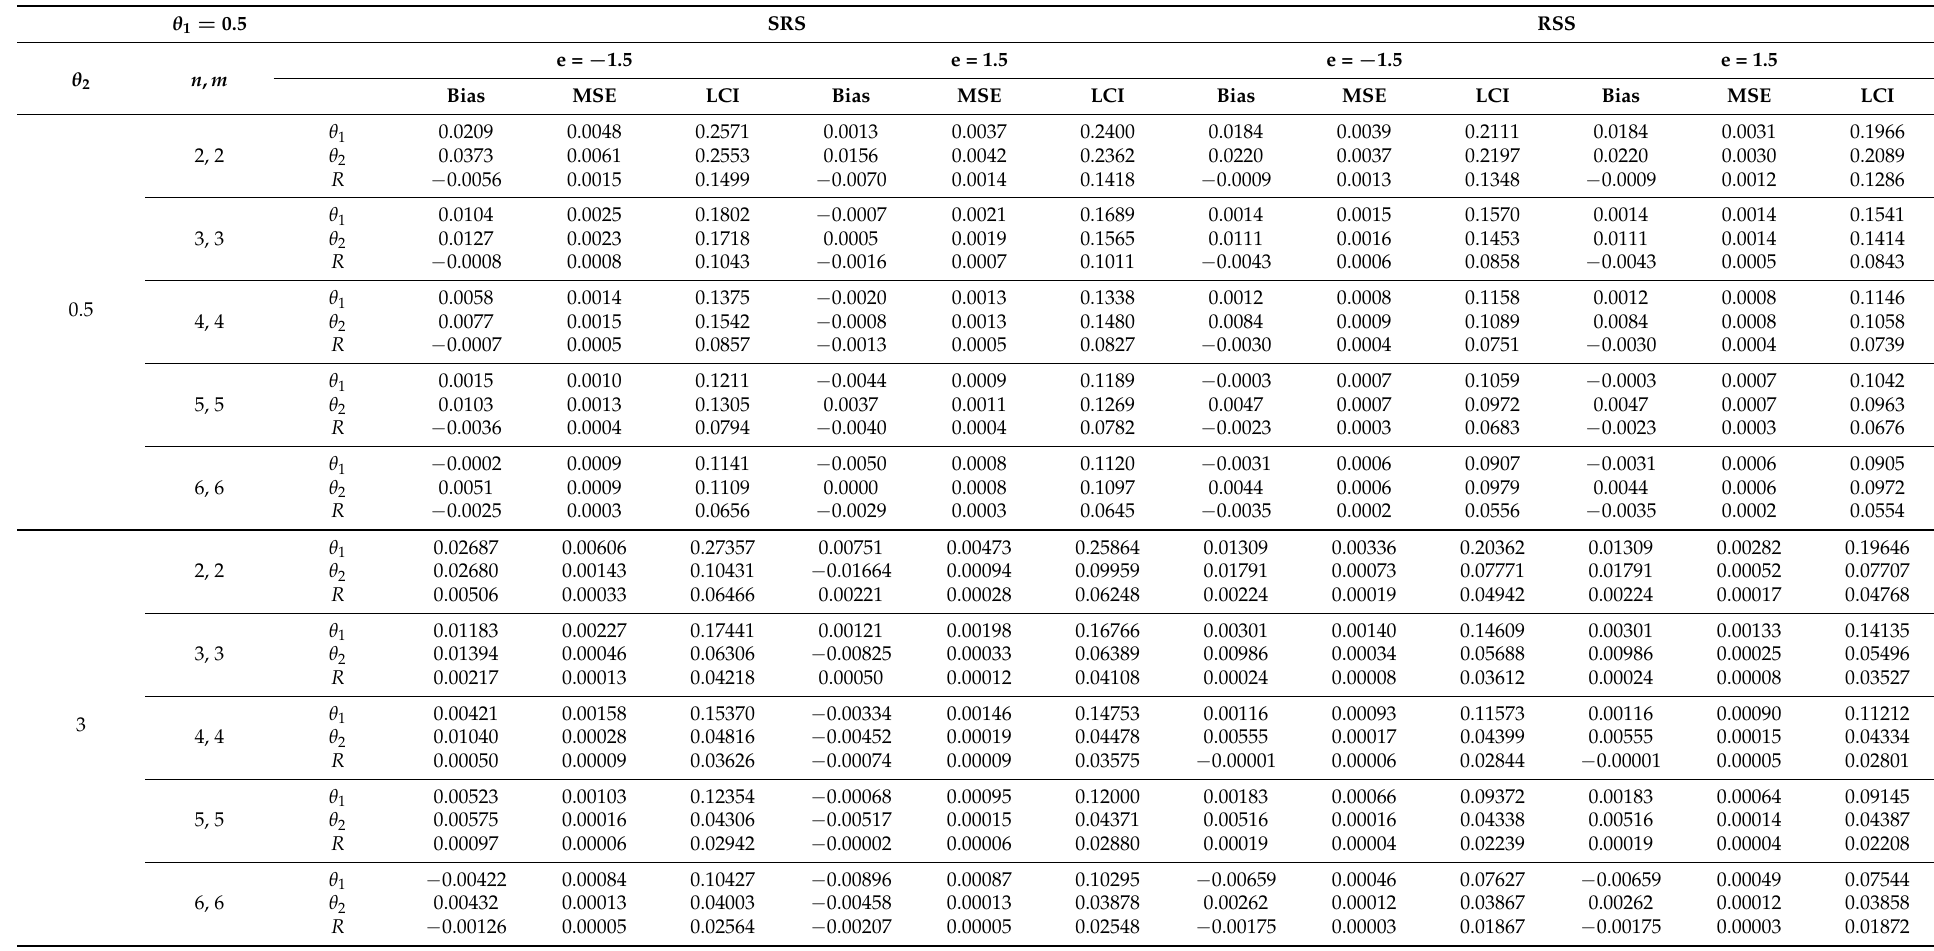
Table 4. SRS and RSS by Bayesian Method with Gamma Prior under LINEX Loss Function of Parameters and R of ITL Stress Strength Model θ 1 =